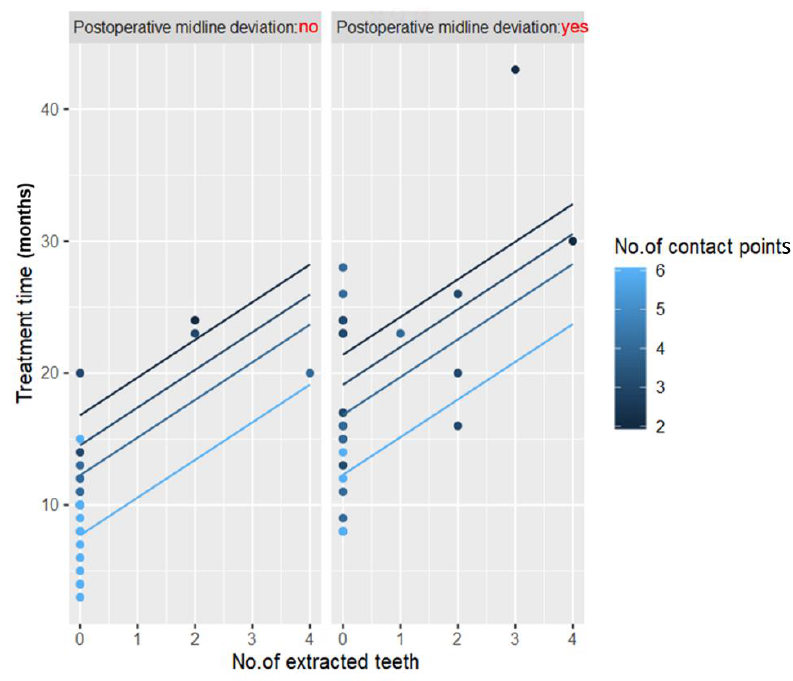
Figure 3. Graph showing the results of multiple regression analysis. Figure 4. Graph showing the results of multiple regression